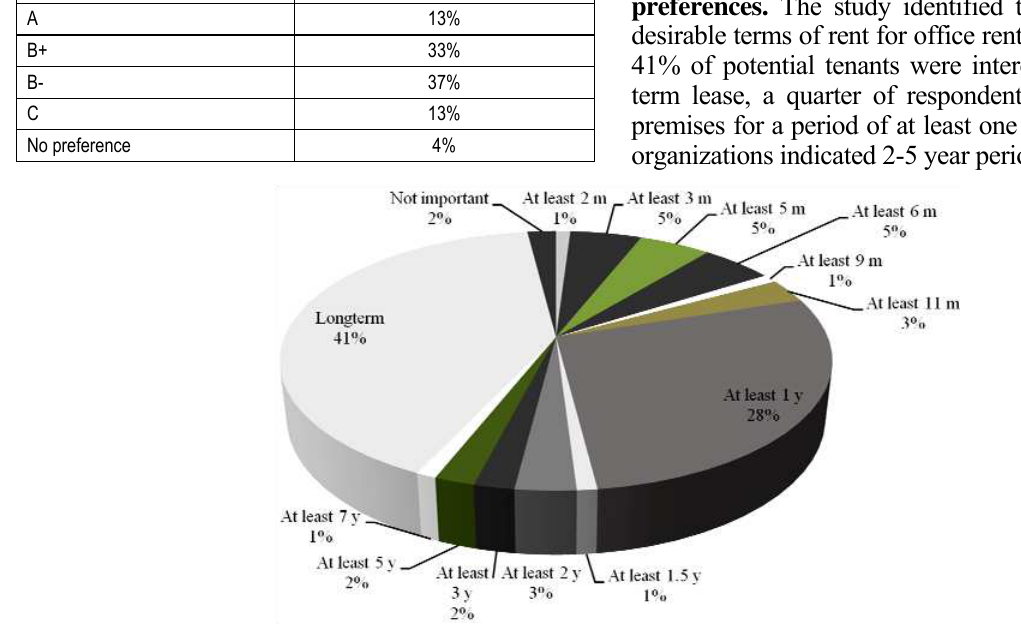
Fig. 3. Desirable terms of rent in the retail and office